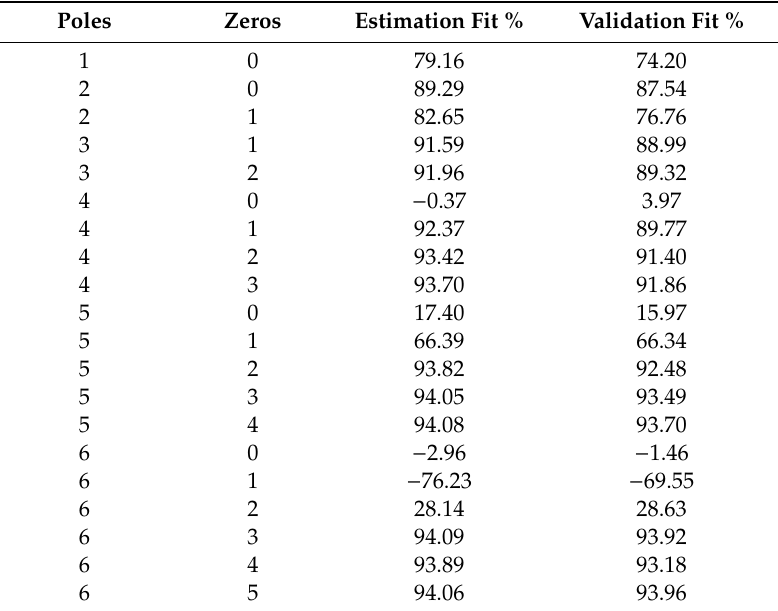
Table 2. Fitting by trial and